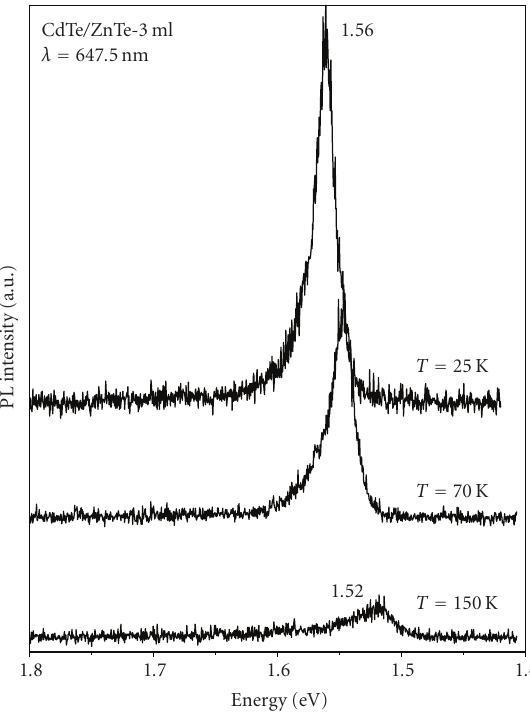
Figure 5: Typical PL spectra of sample with 3ml of CdTe in the finishing layer; PL spectra are excited by λ = 647 . 5 nm Kr-laser line and recorded at di ff erent